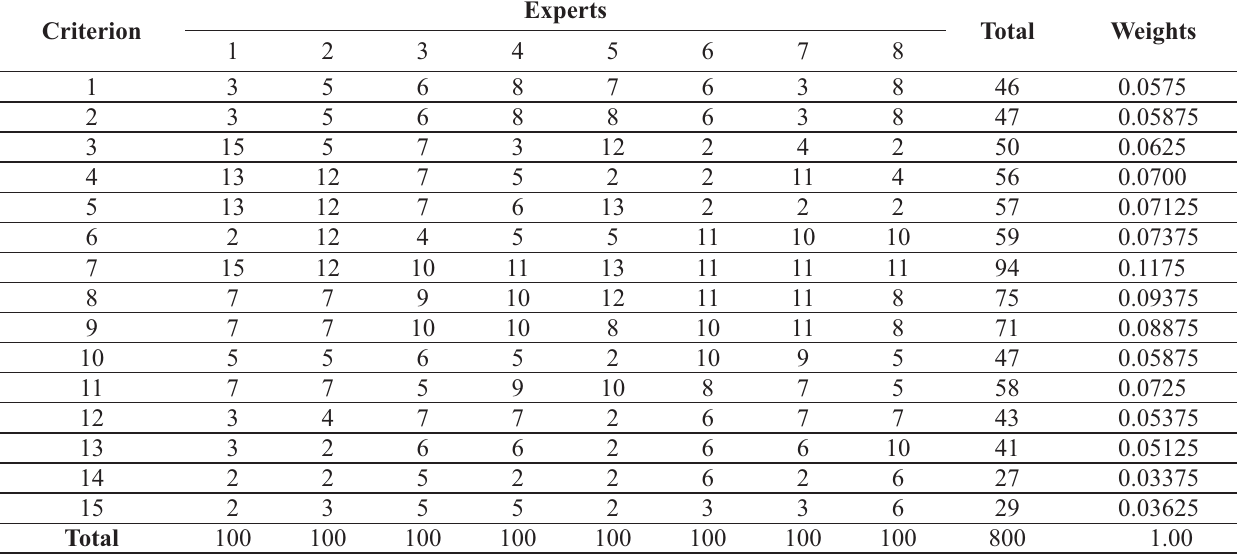
Table 3 . Expert estimates of Group 2 criteria